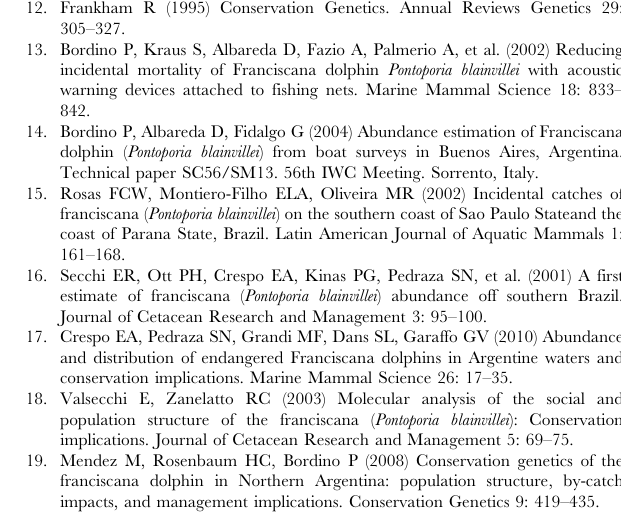
Text S1 Supporting